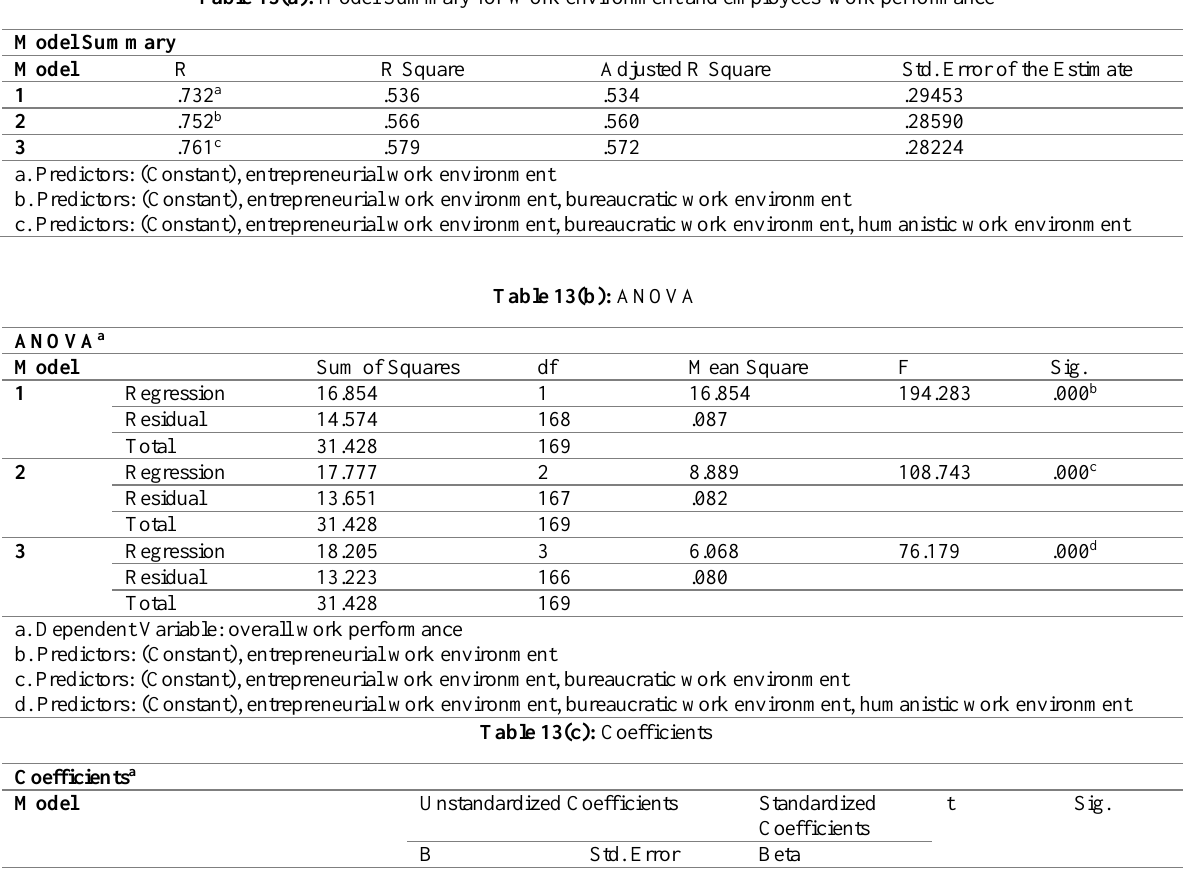
Table 13(a): Model Summary for Work environment and employees' work